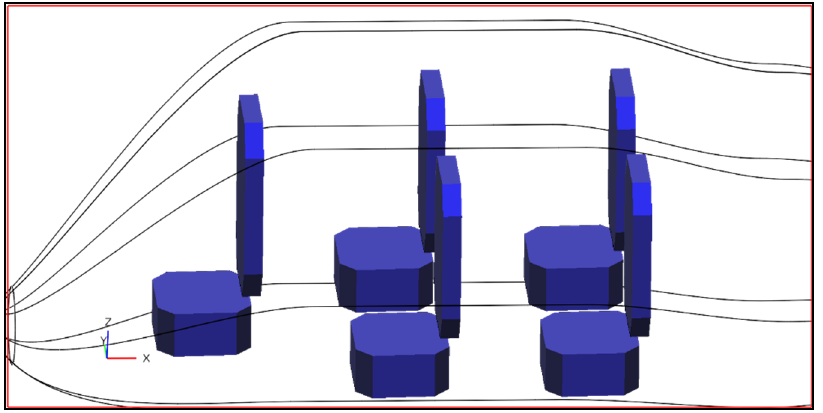
Figure 9. Fuselage internal layout of the present design.